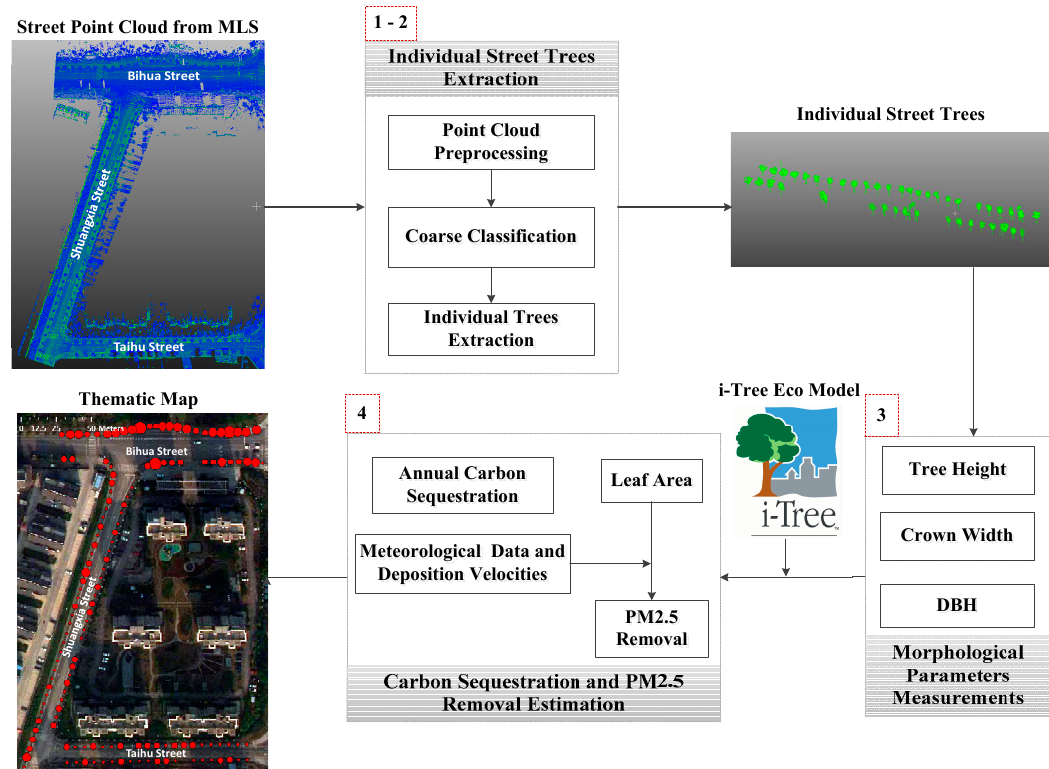
Figure 3. Flow chart of evaluating carbon sequestration and PM 2.5 removal of street trees with MLS data.